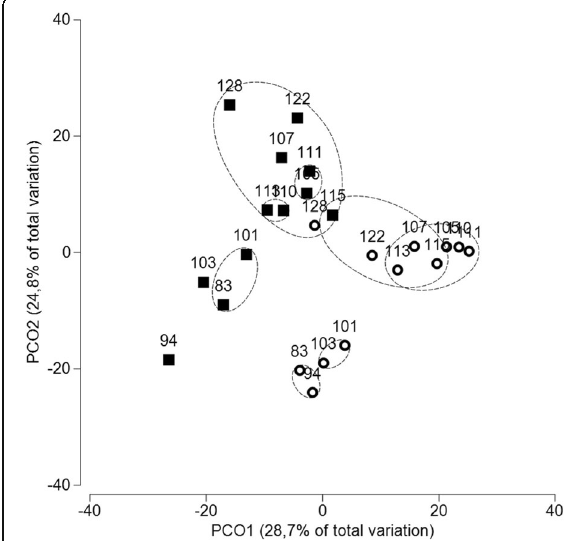
Fig. 2 Principal coordinate analysis using the combined factor DgxBa ( D. geminata x basins). The numbers represent the basin codes. White circles are the non-invaded basins; black circles are the basins invaded by. D. geminata . The dashed ovals show the significant groups found by SIMPROF. Biobio River Basin (83), Tolten River Basin (94), Valdivia River Basin (101), Bueno River Basin (103), Puelo River Basin (105), Yelcho River Basin (107), Palena and coastal Rivers in the Southern Limit of the Tenth Region River Basin (110), Coastal and Island Rivers Between Palena River and Aysen River Basins (111), Aysen River Basin (113), Baker River Basin (115), Coastal Rivers Between Seno Andrew and Hollemberg River and Rivers to the East River Basins (122), and Tierra del Fuego